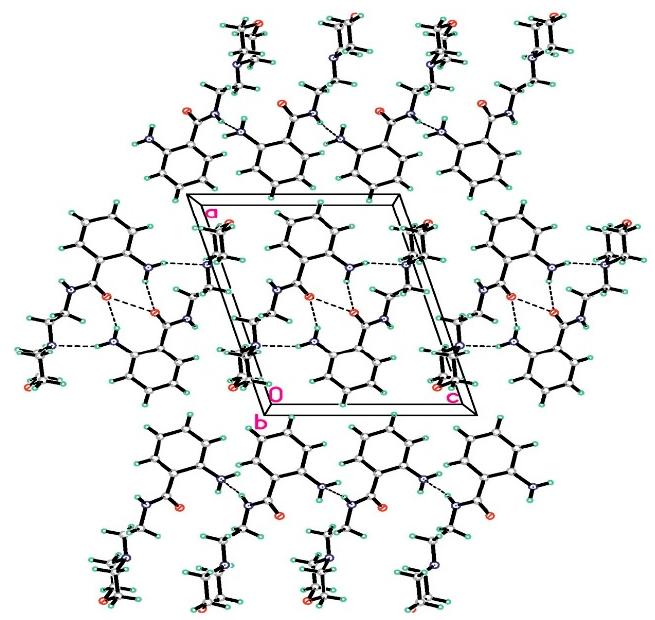
Figure 2. Oak Ridge Thermal Ellipsoid Plot (ORTEP)diagram of the titled compound; displacement ellipsoids are plotted at the 40% probability level for non-H atoms.